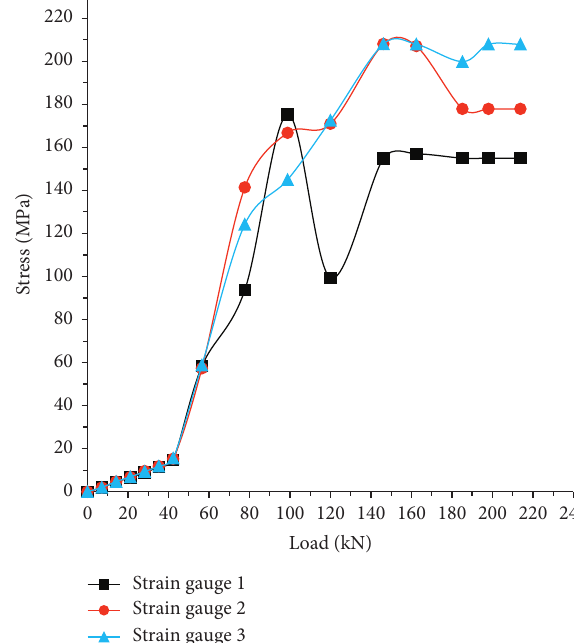
Figure 17: Stress/load curves of the LPCSHTHSC rebars in the midspan section along the short-span direction.